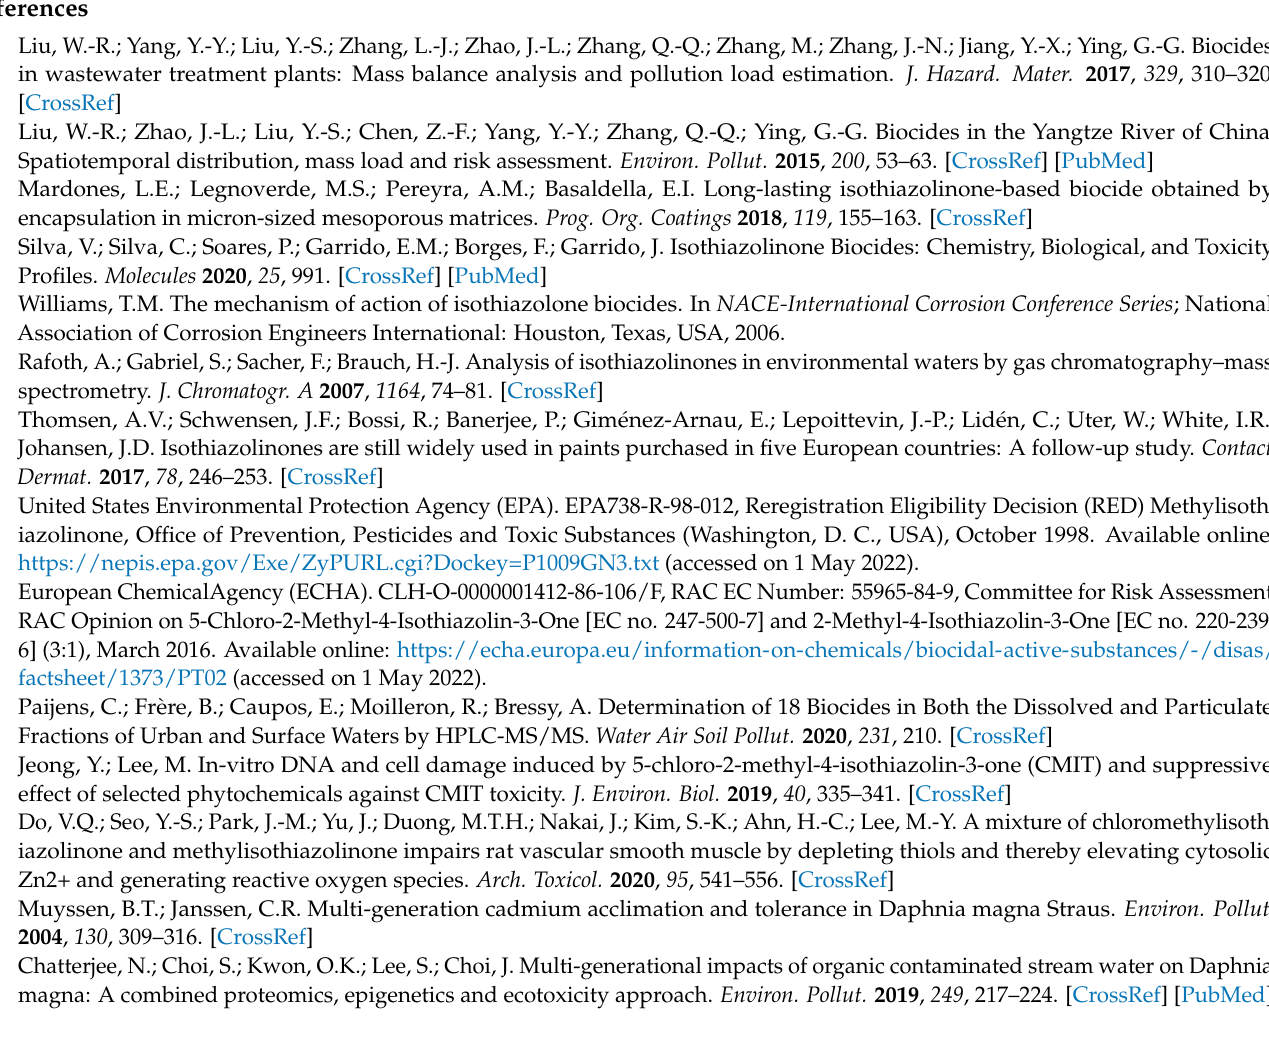
Table S3: Acute lethal concentrations (LCs) and chronic effective concentrations (ECs) of CMIT/MIT in Daphnia magna , Table S4: Differentially expressed proteins (DEPs) after exposure to EC 20 CMIT/MIT compared with the control group in the parental generation (P0) of Daphnia magna . Refs [48–50] has been